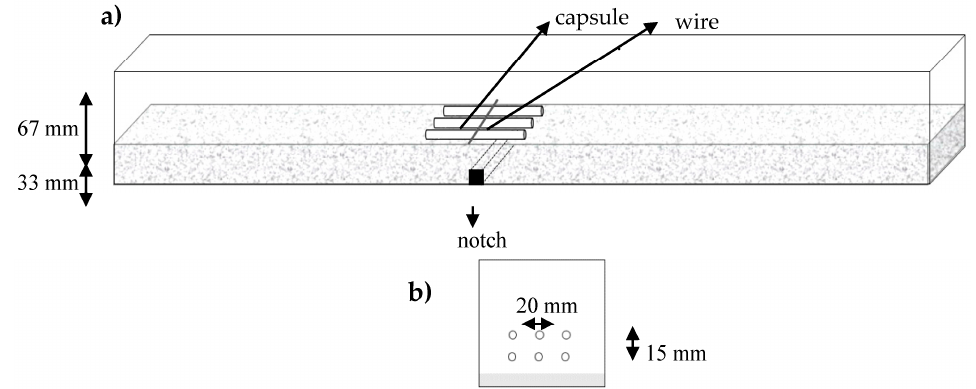
Figure 13. ( a ) The process of placing the first layer of three capsules inside concrete beams, the wire keeps the capsules in place; and ( b ) the cross section with two layers of capsules.